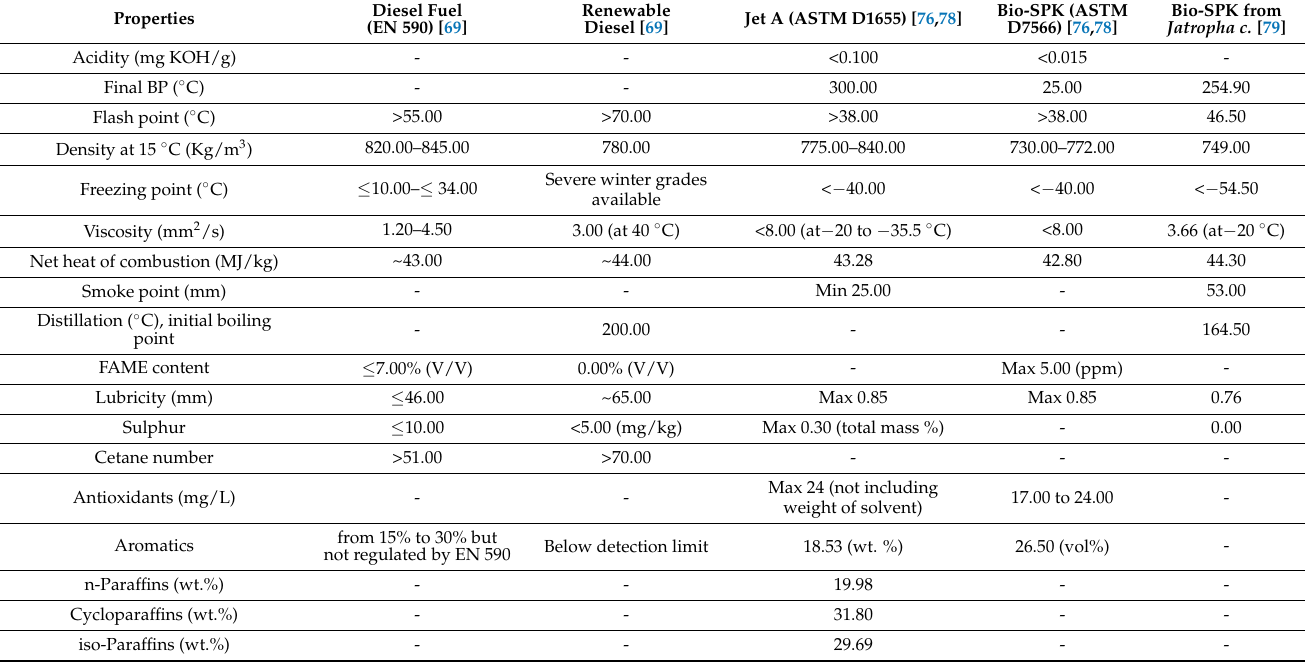
Table 3. Specifications and properties of various road and jet biofuels as compared with fuel